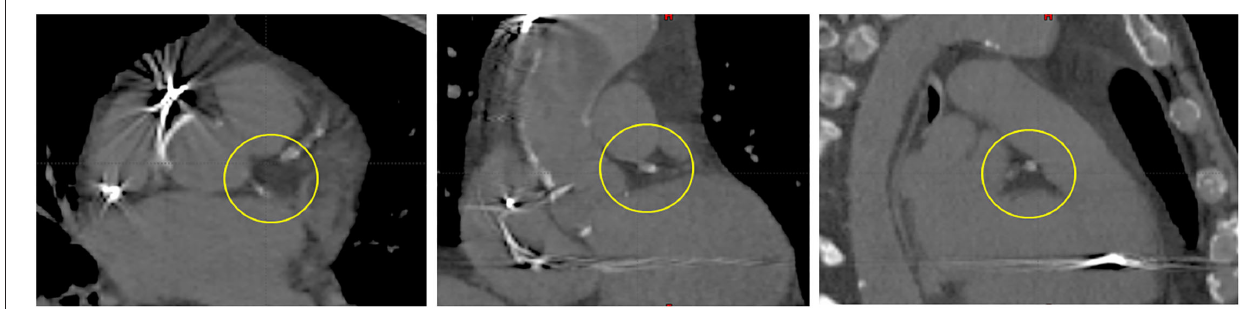
FIGURE 1 | LMCA region (circled)—a visible heterogeneity used as the primary target surrogate inside a heart (RefSTRUCT). From left to right: transverse, coronal, and sagittal